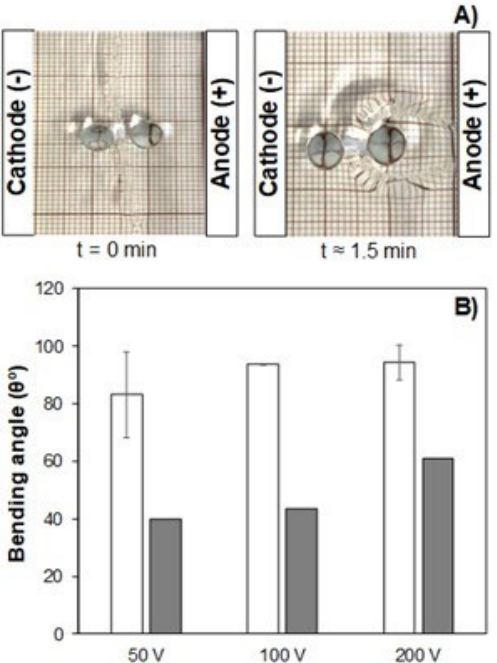
Figure 14. Illustration of T-T hydrogel actuation response under 100 V ( A ), and bending angles at the different applied electrical stimulus for T-T (white columns) and T-G (grey columns) IL-based polycationic hydrogels ( B ). Experiments were conducted in deionized water at room temperature (~22 °C) [12]. Reproduced with permission from Elsevier.